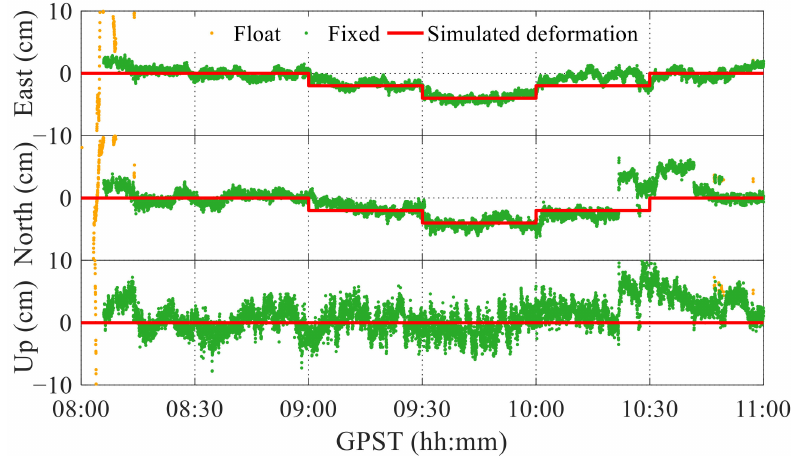
Figure 15. Results of simulated dynamic deformation monitoring using